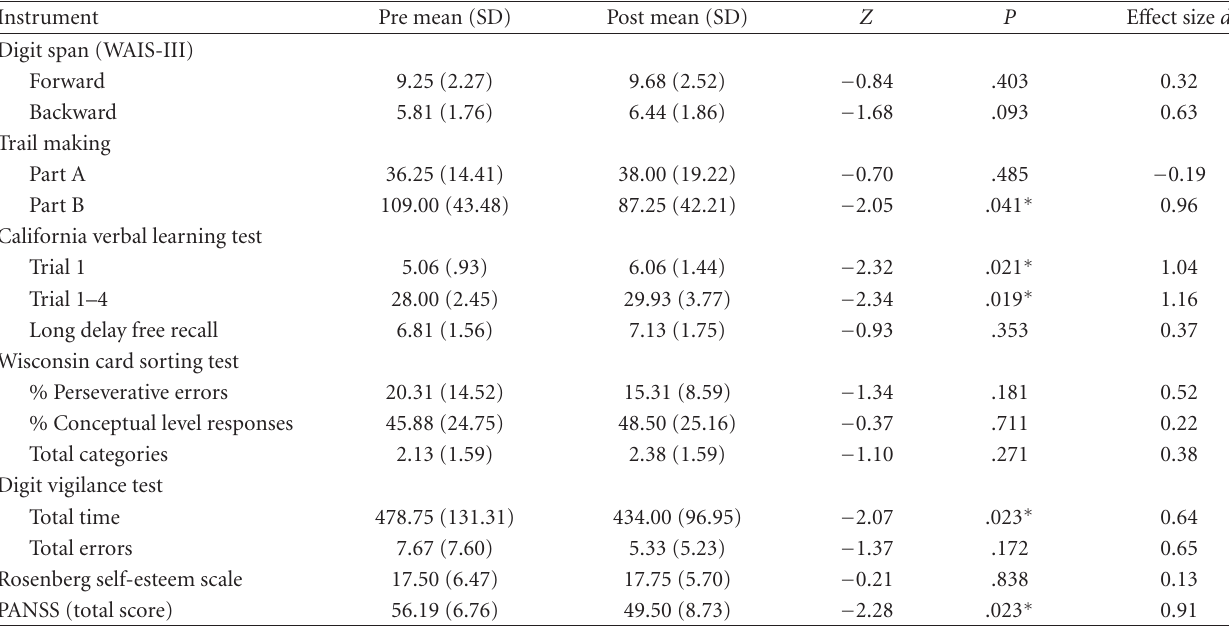
Table 1: Pre-post evaluation of cognitive